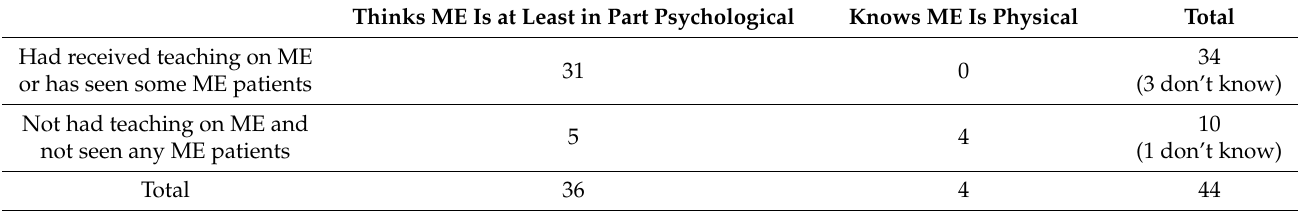
Table 3. Effect of previous teaching or experience on understanding of